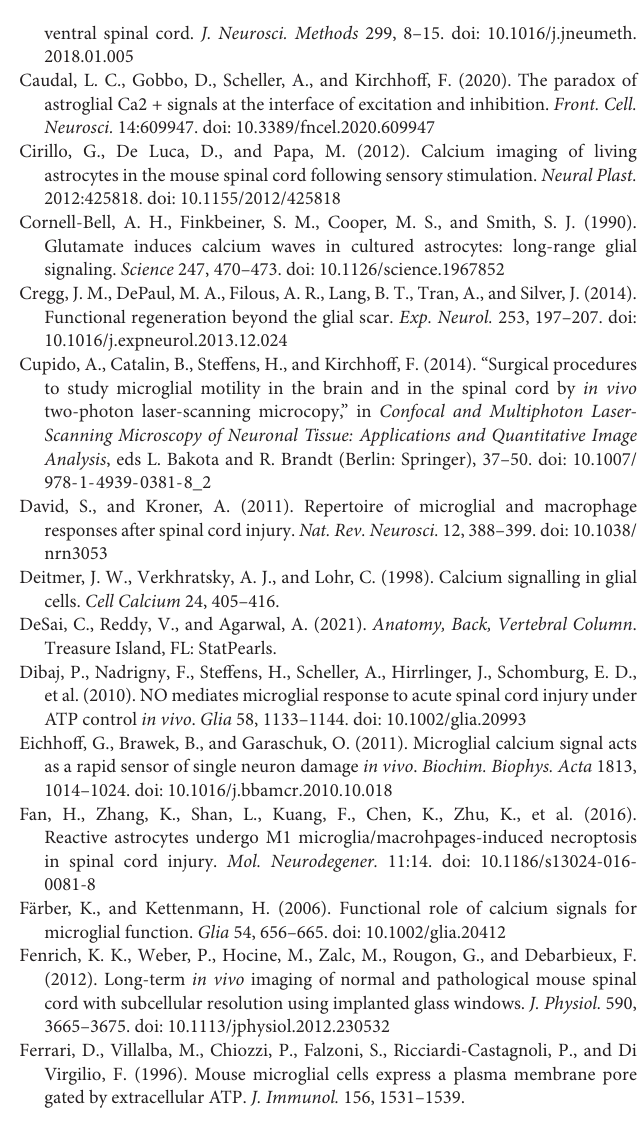
400 µ m 2 (5.3 ± 1.8%) were excluded from the representation for easier display. Data were represented as mean ± SEM, fitted with a lognormal curve using a Least-Squares fitting with no weighting method and compared using the extra-sum-of-squares F test. F ratios and relative p-values of single curve comparisons were schematically represented as a triangle diagram and gray-scaled color-coded. Non-significantly different curves were plotted as a shared curve ( d1 ∼ d2 ∼ d7 ). Smaller insets represent magnified views of the fitting curves. N (animals) = 4 (astroglia, d0 ), 4-6-4 (astroglia, in vivo , d1-d7 ), 6 (microglia, d0 ), 4 (microglia, in vivo , d1-d7 ). n (FOVs) = 14 (astroglia, d0 ), 13-20-13 (astroglia, in vivo , d1-d7 ), 22 (microglia, d0 ), 14-13-10 (microglia, in vivo , d1-d7 ). Supplementary Figure 4 | Hierarchical clustering of Ca 2 + signalling data. (A) Heatmap of the unsupervised hierarchical clustering of Ca 2 + signaling data represented as medians of single FOVs and color-coded based on the row z -scores for both cell-types, (B) astroglia or (C) microglia. Datasets were color coded based on cell-type (astroglia, blue; microglia, yellow), experimental procedure ( ex vivo , light blue; in vivo , orange) or spinal cord region ( gm , gray; wm ,